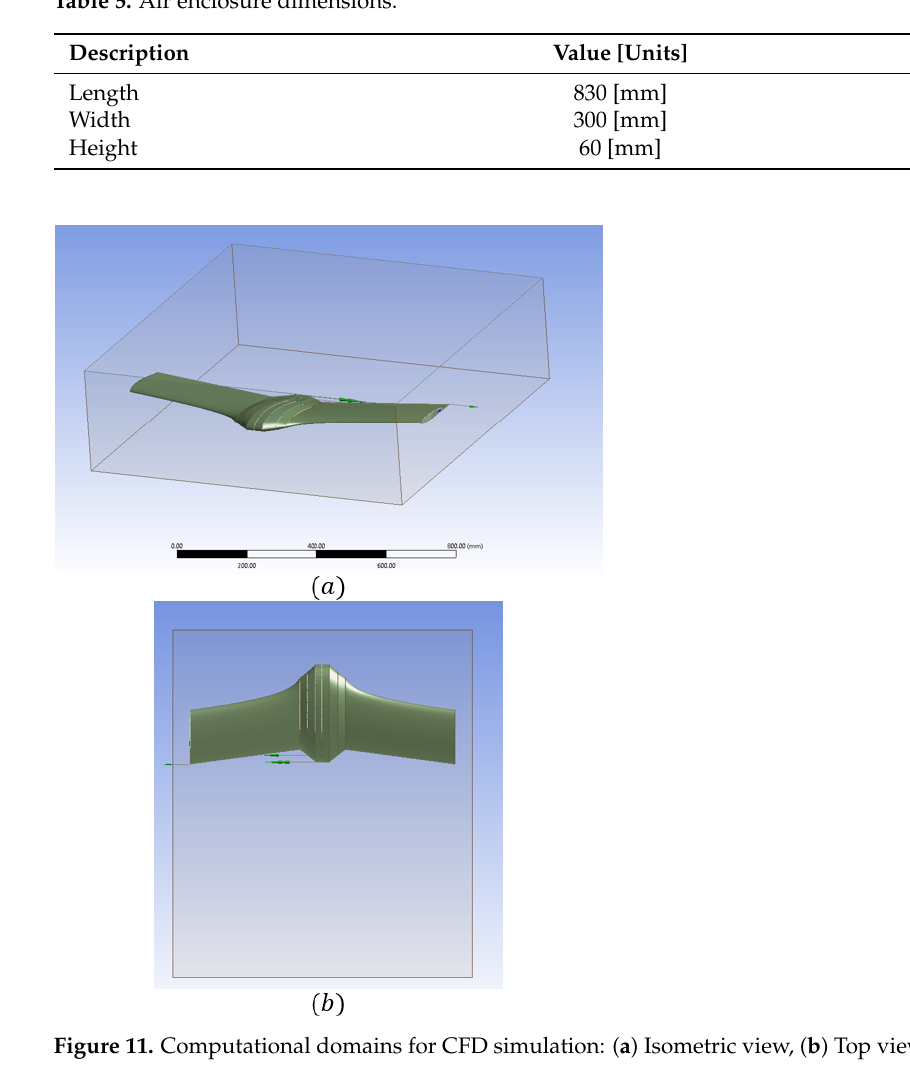
Table 5. Air enclosure dimensions.